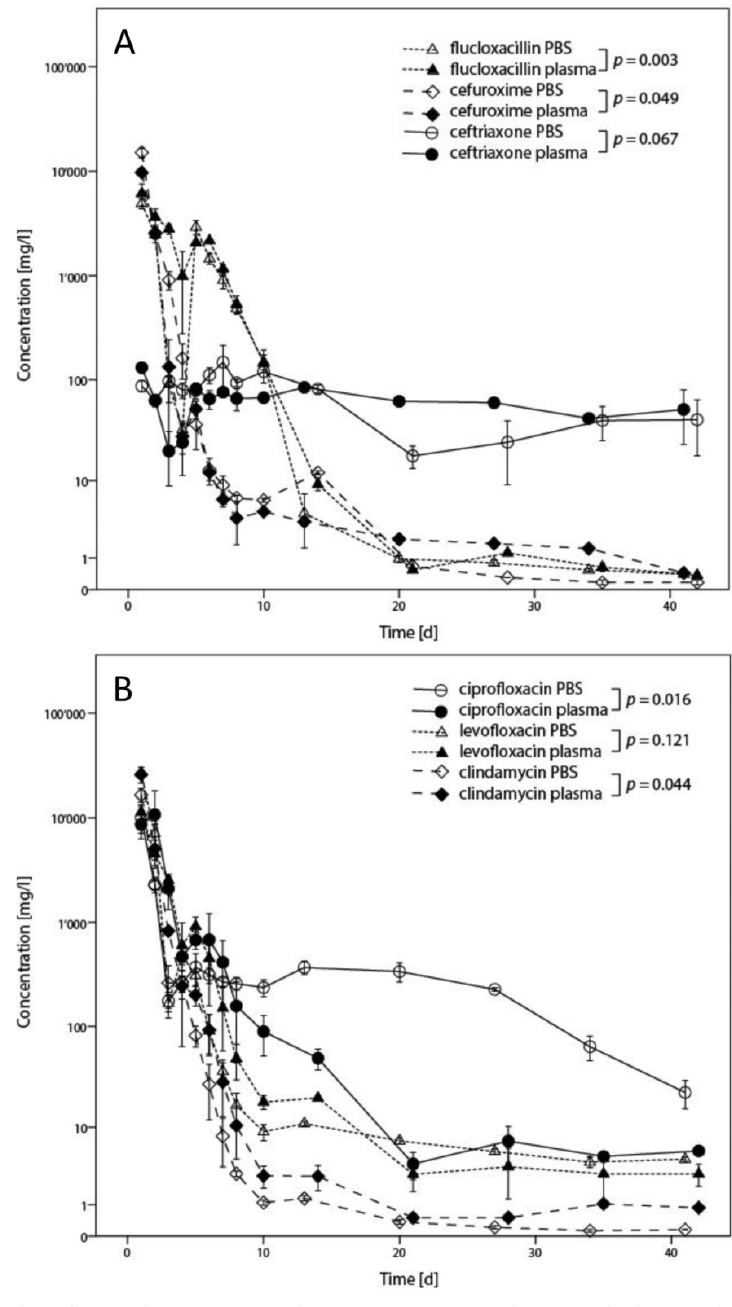
Figure 3. Results from determination of concentration in the elution fluids by HPLC-MS indicated for both PBS and plasma. In Fig. 3A, results for flucloxacillin, cefuroxime, and ceftriaxone are presented. Fig. 3B shows the results for ciprofloxacin, levofloxacin and clindamycin. Results are presented as means from triplicates with error bars indicating standard deviation, with statistical analysis of the comparison between results in PBS and plasma indicated in the